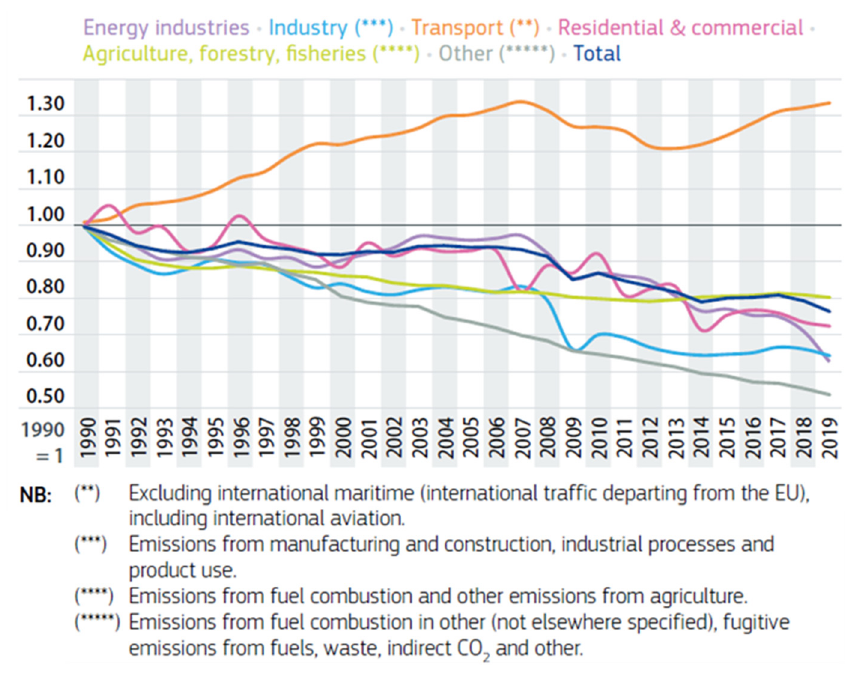
Figure 1. Million metric tons of CO 2 equivalent in EU-27 from 1990 to 2019 divided by sectors; from [1].